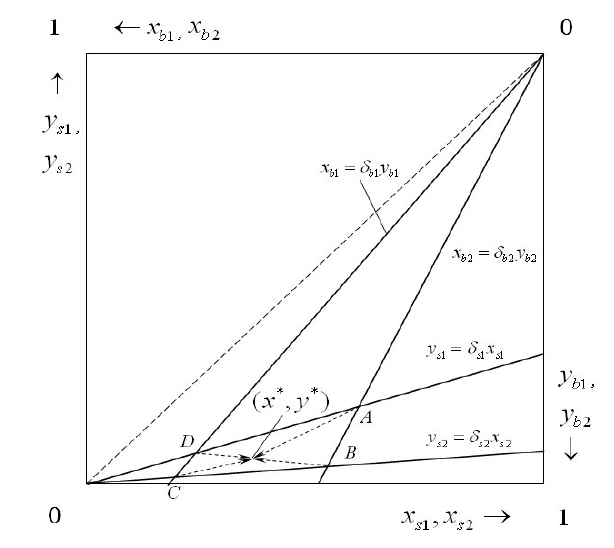
Figure 2. Relationship between two-player bargaining and two pairs of players